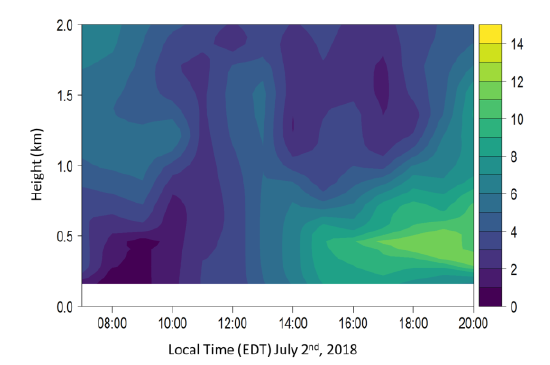
Fig. 5 uWRF Horizontal Wind Speed Plots of the Halo Pro and Streamline